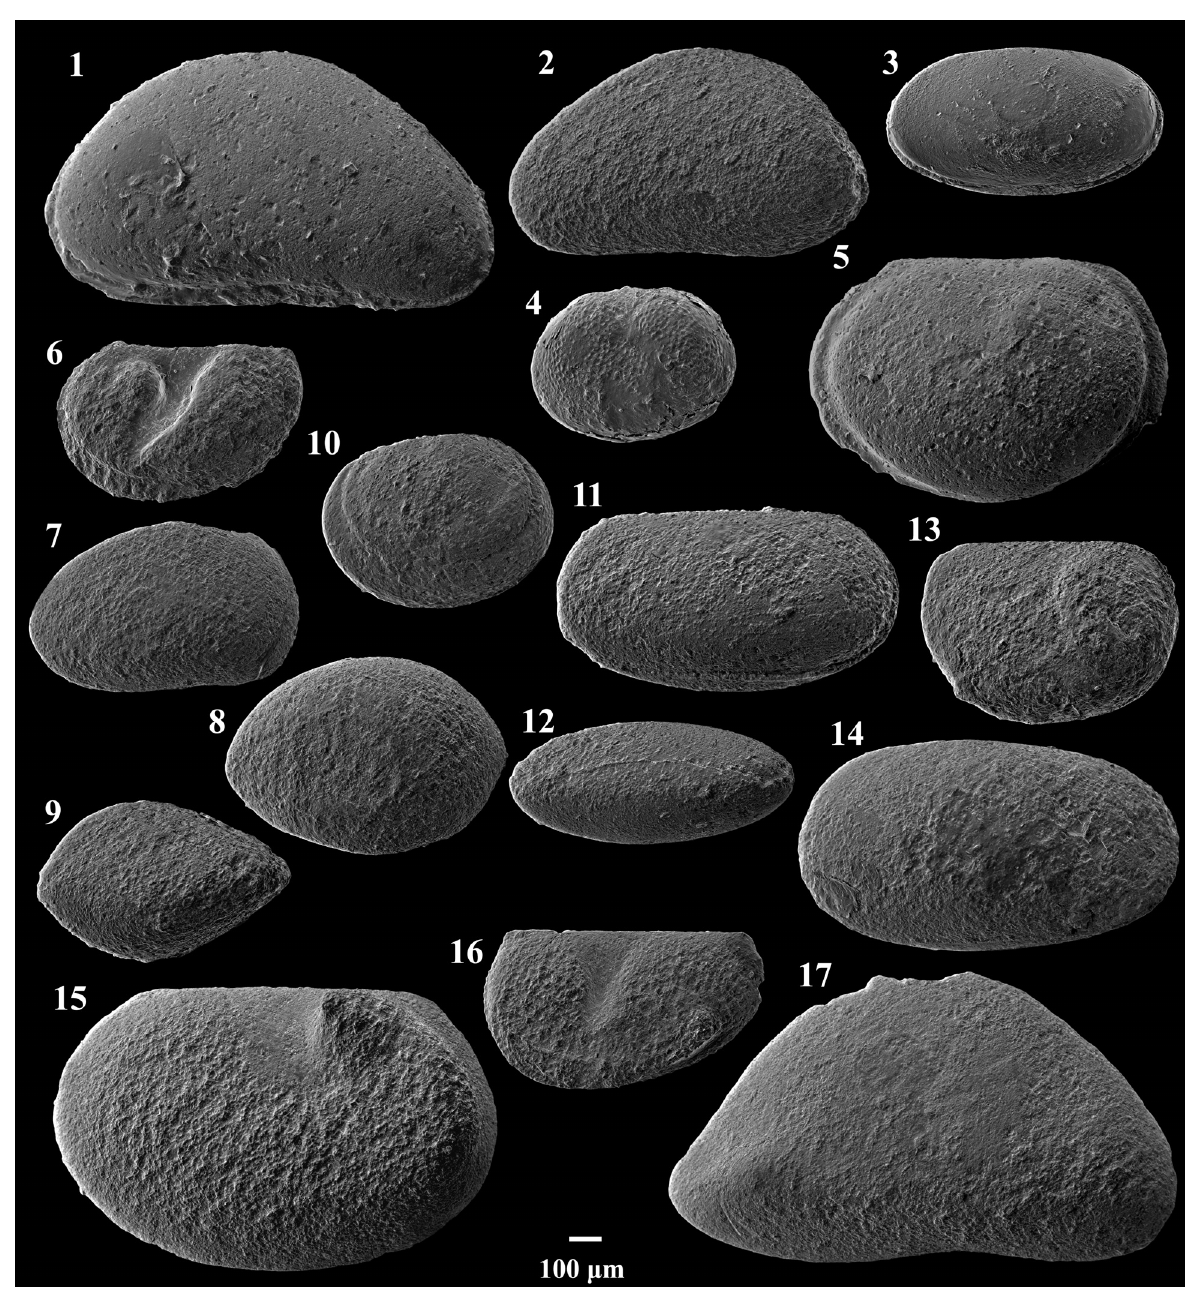
Fig. 4. Selected ostracods from the Stačiunai (1–3), Kuldiga (4), Saldus (4) and Jelgava (6–17) formations of the Jūrmala core. 1 , 2 , Longiscula smithii (Jones); 1, right lateral view, TUG 1820­1, sample 992, depth 717.6 m; 2, juvenile carapace, TUG 1820­2, left lateral view, sample 996, depth 716.2 m. 3 , Microcheilinella rozhdestvenskaja Neckaja, juvenile carapace, right lateral view, TUG 1820­3, sample 992, depth 717.6 m. 4 , Circulinella gailitae Meidla, juvenile right(?) valve, TUG 1820­4, sample 83, depth 742 m. 5 , Gen. A sp. n., TUG 1820­5, sample 85, depth 736.5 m. 6 , Sigmobolbina camarota , juvenile left valve, TUG 1820­6, sample 79, depth 748 m. 7 , Daleiella rotundata Meidla, juvenile right valve, TUG 1820­7, sample 79, depth 748 m. 8 , Daleiella rotundata Meidla, juvenile left valve, TUG 1820­8, sample 79, depth 748 m. 9 , Daleiella rotundata Meidla, juvenile carapace, ventral view, TUG 1820­9, sample 79, depth 748 m. 10 , Easchmidtella sp., right valve, TUG 1820­10, sample 79, depth 748 m. 11 , 12 , Elliptocyprites sp.; 11, right(?) lateral view, TUG 1820­ 11, sample 79, depth 748 m; 12, juvenile carapace, ventral view, TUG 1820­12, sample 79, depth 748 m. 13 , Airina cornuta Neckaja, right valve, TUG 1820­13, sample 79, depth 748 m. 14 , Rectella romboformis Neckaja, left lateral view, TUG 1820­14, sample 79, depth 748 m. 15 , Kinnekullea thorslundi Henningsmoen, right valve, TUG 1820­15, sample 79, depth 748 m. 16 , Hippula edolensis (Gailīte), right valve, TUG 1820­16, sample 79, depth 748 m. 17 , Pullvillites laevis Abushik & Sarv, right valve, TUG 1820­17, sample 79, depth 748